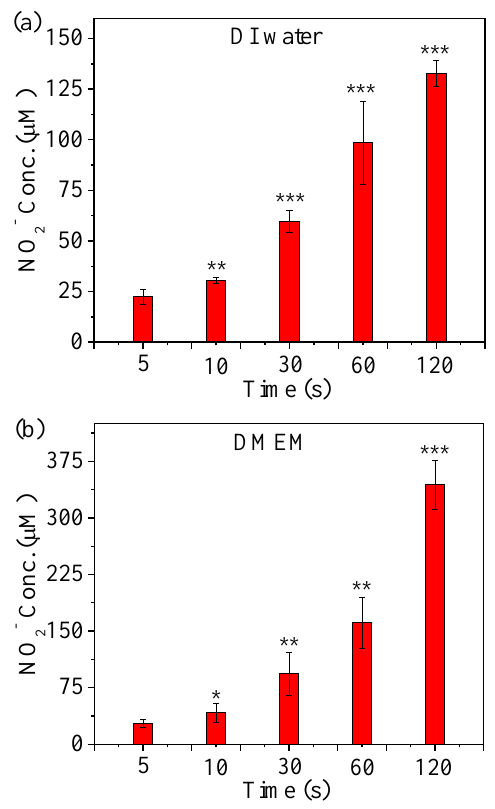
Figure 3. RNS concentration in He µCAP-treated DI water ( a ) and DMEM ( b ). Student t-test was performed, and the statistical significance compared to µCAP 5 s treatment is indicated as * p < 0.05, ** p < 0.01, *** p < 0.001. ( n = 3).